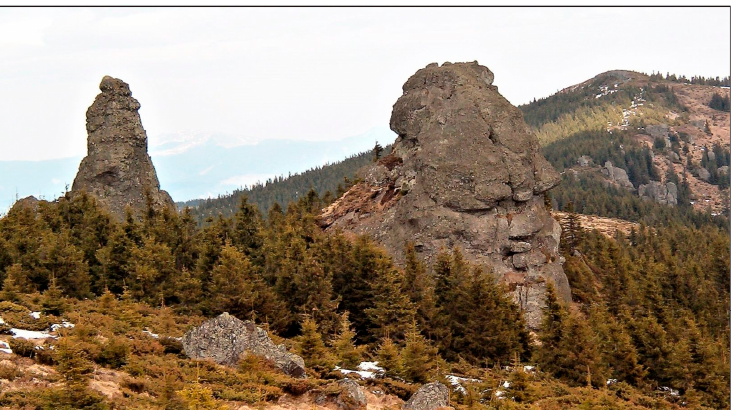
Figure 18. Two of the spectacular “12 Apostles” residual rock formations resulted from selective wind erosion of volcaniclastic rocks in the north-western part of the C ă limani Mountains (Photo credit: Viorel Chiri ță ).